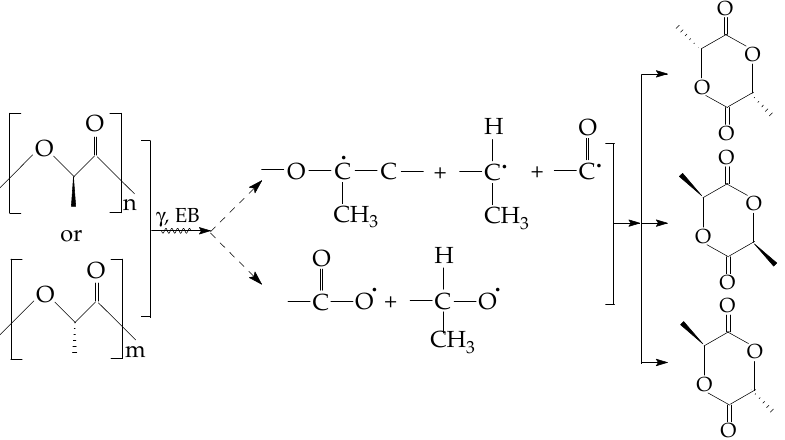
Figure 1. The radical intermediates that precede the formation of stable oxygenated products during degradation.